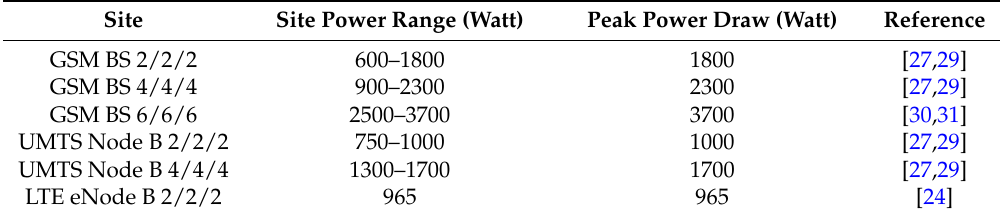
Table 1. Total power consumption of a typical macro-BS for different cellular generations.